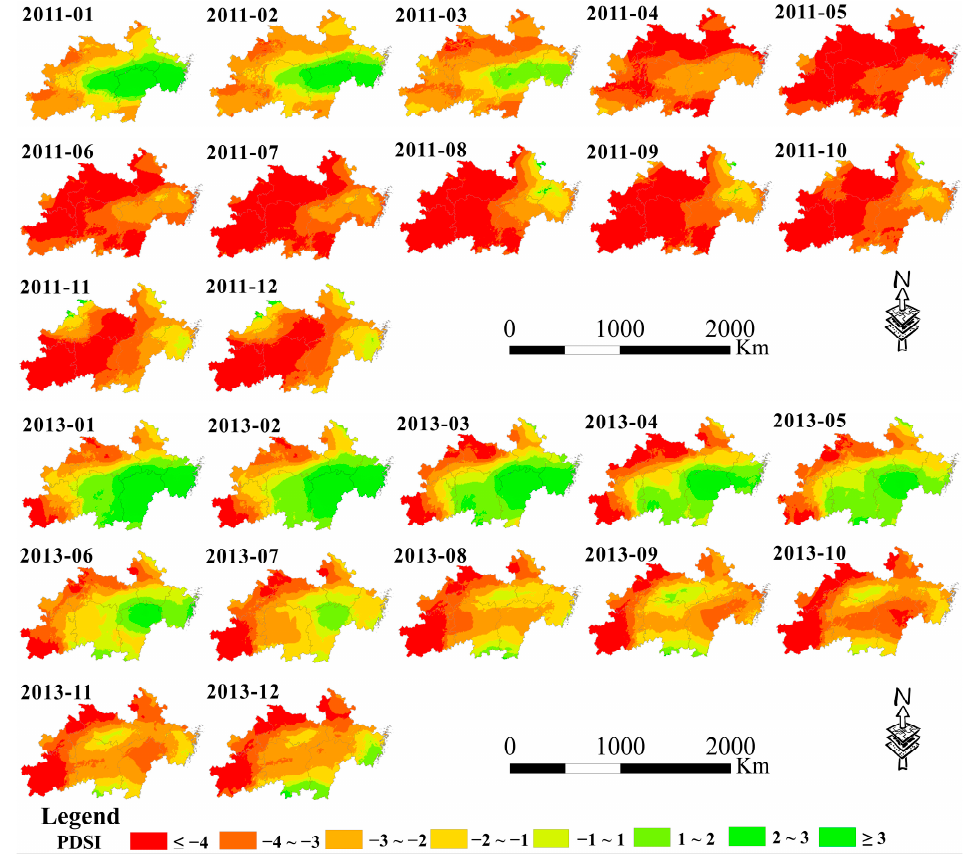
Figure 6. Monthly spatial distributions of the PDSI in the middle and lower reaches of the Yangtze River in China in 2011 and 2013.